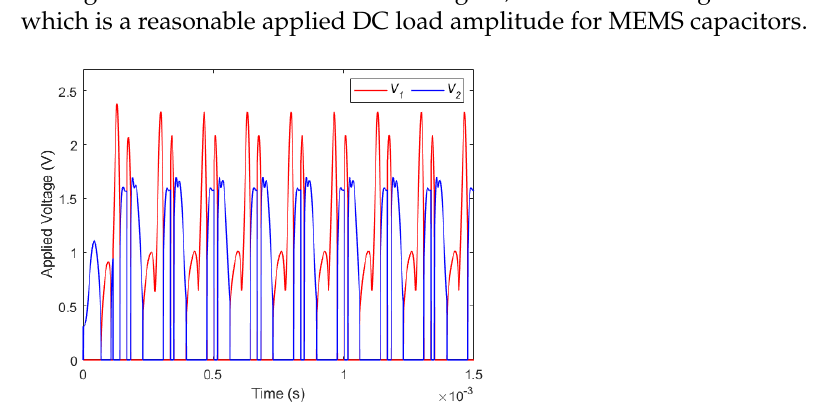
Figure 7. Variation of the control parameters V 1 and V 2 considering p = 19, q = 11, and β = . The variation of the x parameter versus time for various amounts of q was ex- 1